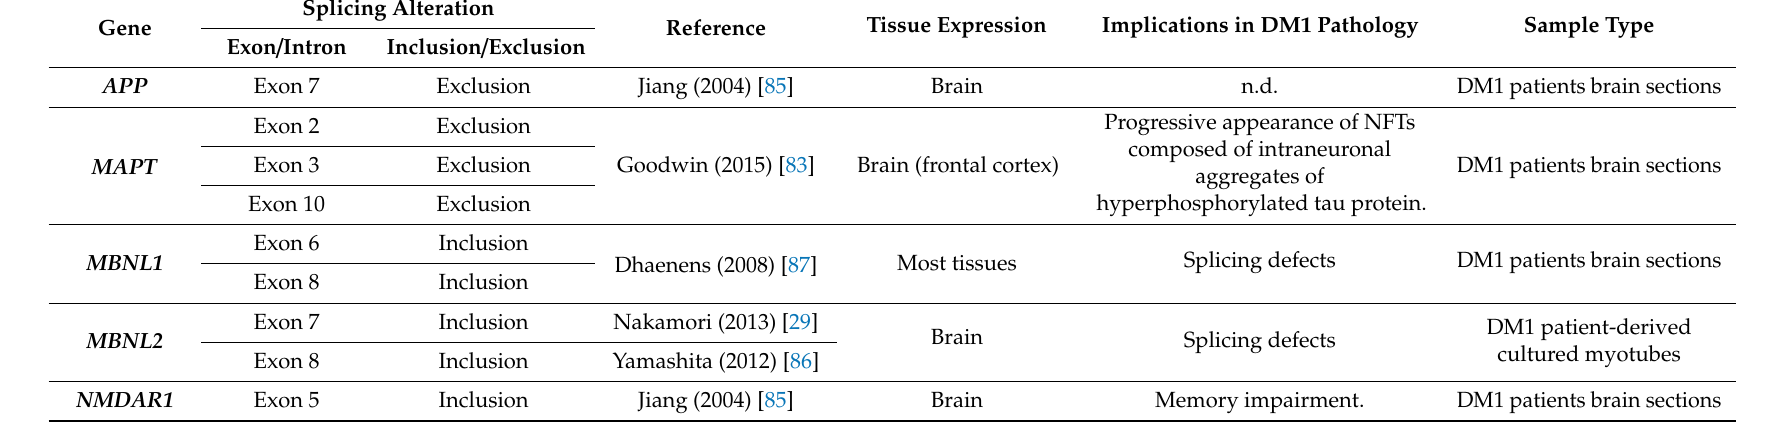
Table 1. Summary of transcripts expressed in brain tissue and altered in human DM1 samples. All genes mentioned are described in the text and represented